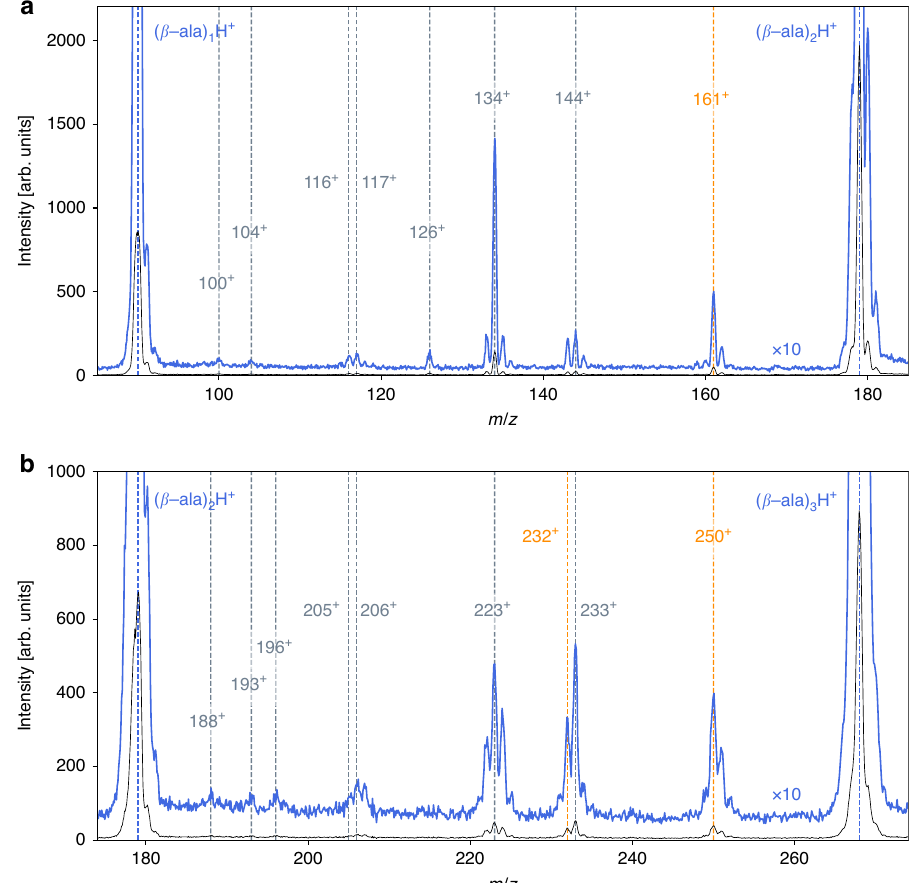
Fig. 1 Fragmentation mass spectra. Singly ionized reaction products of collisions between 30 keV He 2 + projectiles and cold neutral β -alanine clusters. Blue curves correspond to a 10× enhancement of the intensity. a Region between monomer and dimer; b region between dimer and trimer. The numbers indicate the mass-over-charge ratio ( m / z ) of different fragments and products. Peptide species produced after the collision are indicated in orange, while other covalent products are in